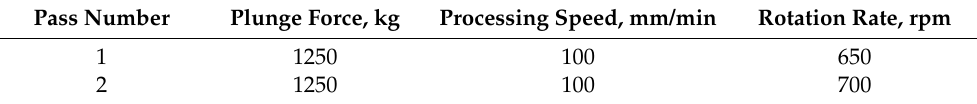
Table 2. The FSP parameters